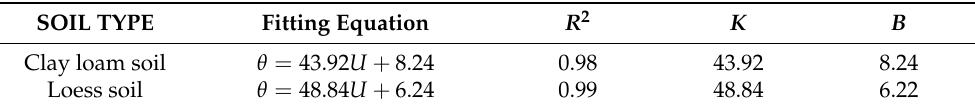
Table 4. Fitting equations for the output voltage of the water content measurement probe and soil water content.